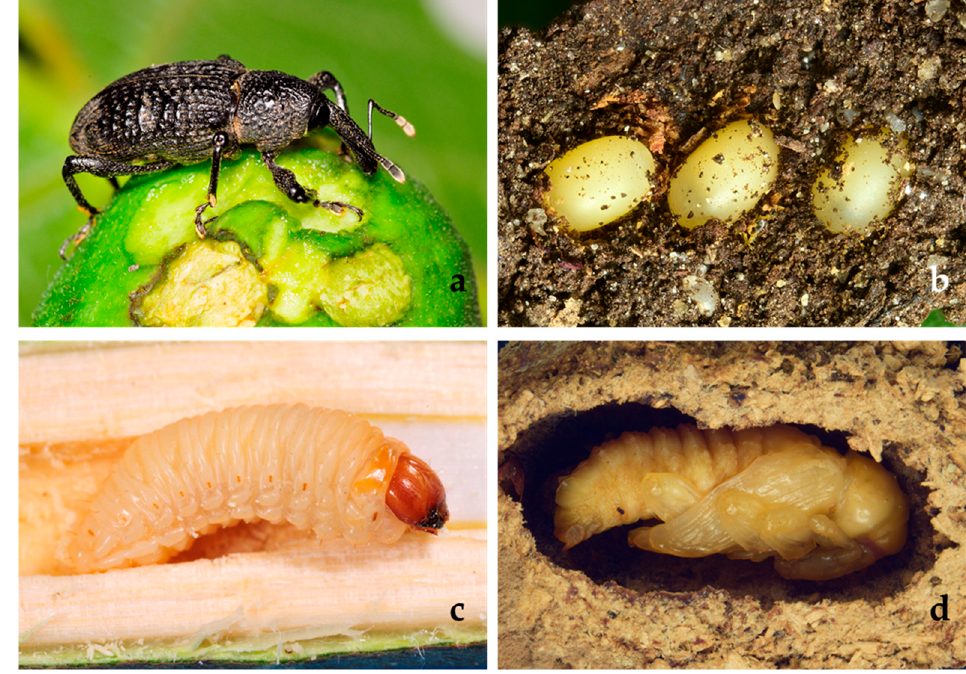
Figure 1. Aclees taiwanensis : ( a ) adult, ( b ) eggs, ( c ) larva, and ( d ) pupa.